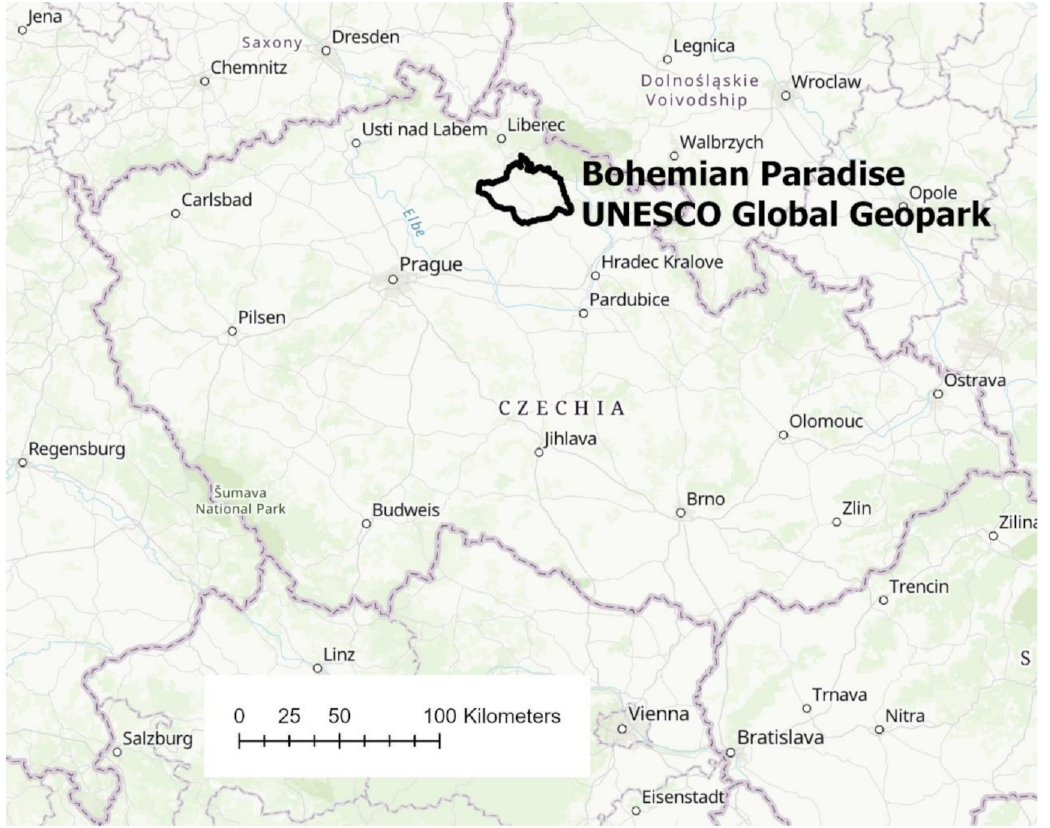
Figure 1. Location of the Bohemian Paradise UNESCO Global Geopark within Central Europe.